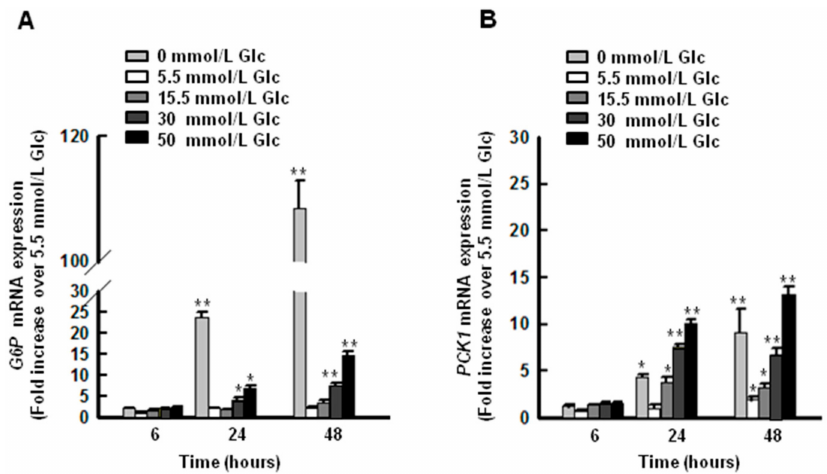
Figure 2. G6P and PCK1 gene expression increase with increasing glucose concentrations in HepG2 cells. Expression of G6P ( A ) and PCK1 ( B ) increased under hyperglycemic conditions (30 and 50 mmol/L glucose in media). The graphs show the mean ± SEM of three independent experiments. (* p < 0.05, ** p < 0.01 vs. 5.5 mmol/L at 24